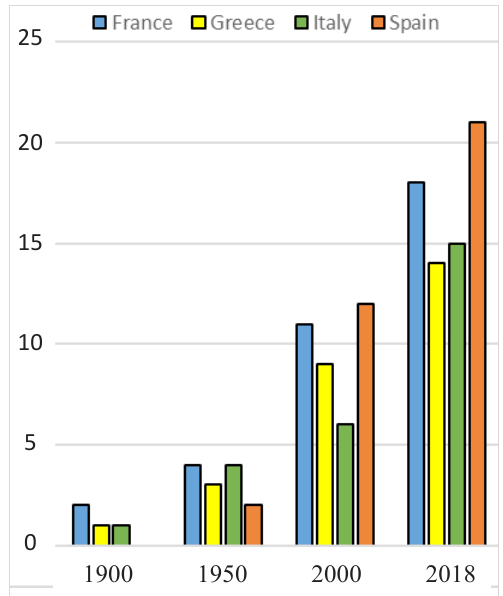
Fig 2. Number of exotic ant species known in France (Corsica, mainland), Greece (Crete, mainland, Peloponnese), Italy (mainland, Sardinia, Sicily) and Spain (mainland) since the beginning of the 1900 th